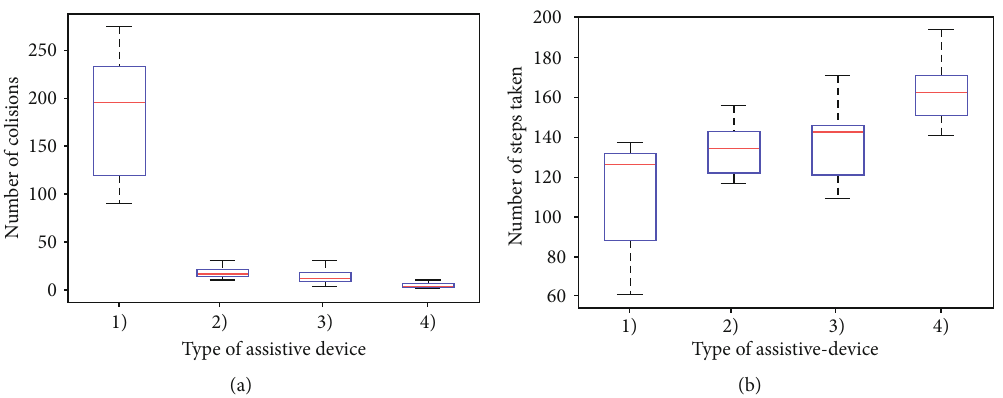
Figure 10: Statistical results: (a) number of cotillions and (b) distance covered. (1) Without any aid, (2) with cane, (3) with belt module only, and (4) with belt and ankle module.